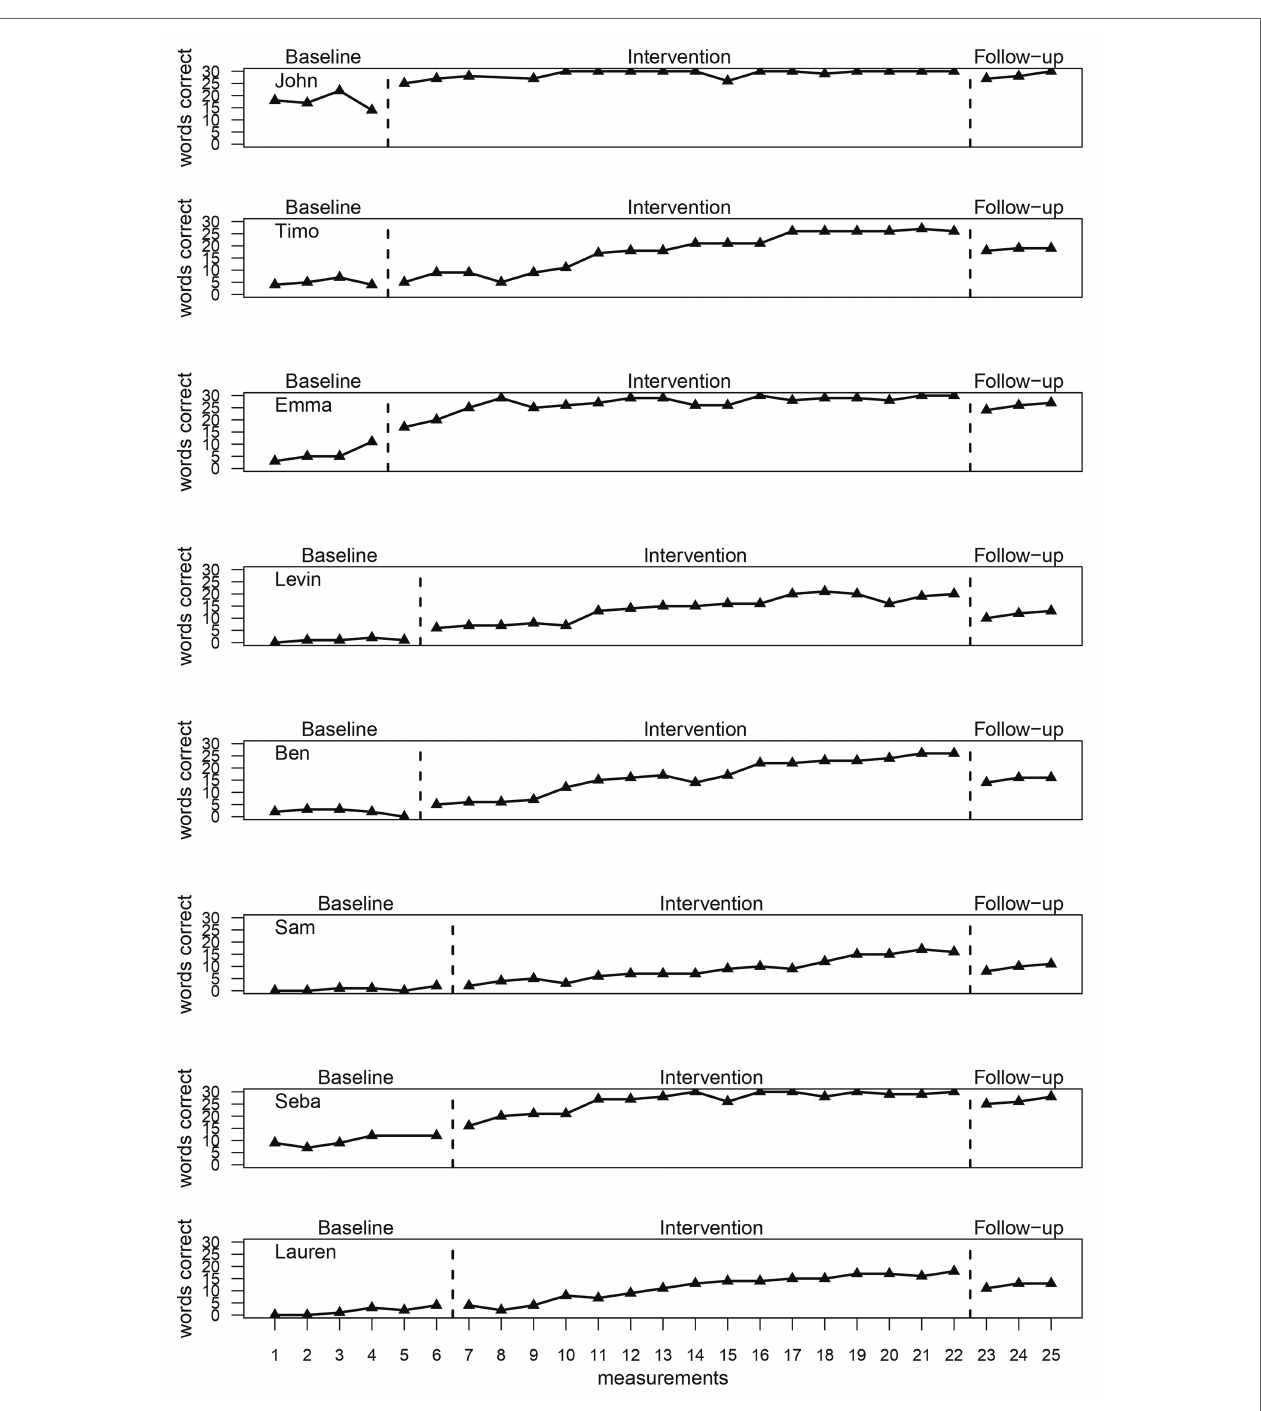
FIGURE 2 | Amount of words read